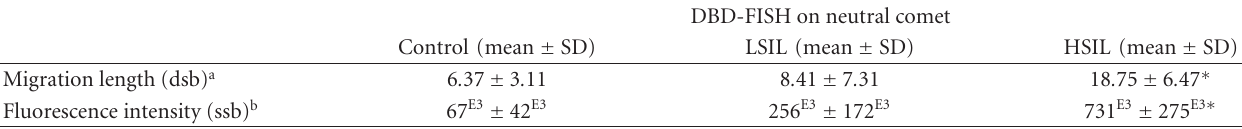
Table 4: DNA damage (ssb + dsb) and dsb evaluated by DBD-FISH on neutral comet in women with LG-SIL, HG-SIL and in control